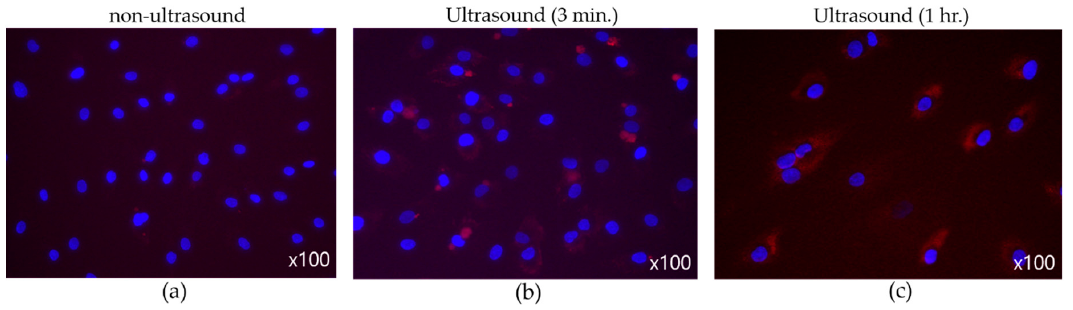
Figure 11. (Flat tip, 40 V pp ) Effect of ultrasound on membrane permeability. ( a ) No sonification, ( b ) three-minute exposure, ( c ) one-hour